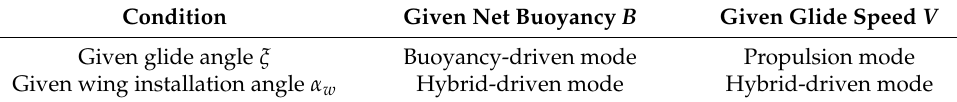
Table 1. The modes that make a higher sailing efficiency in different conditions. Condition Given Net Buoyancy B Given Glide Speed V Given glide angle ξ Given wing installation angle α